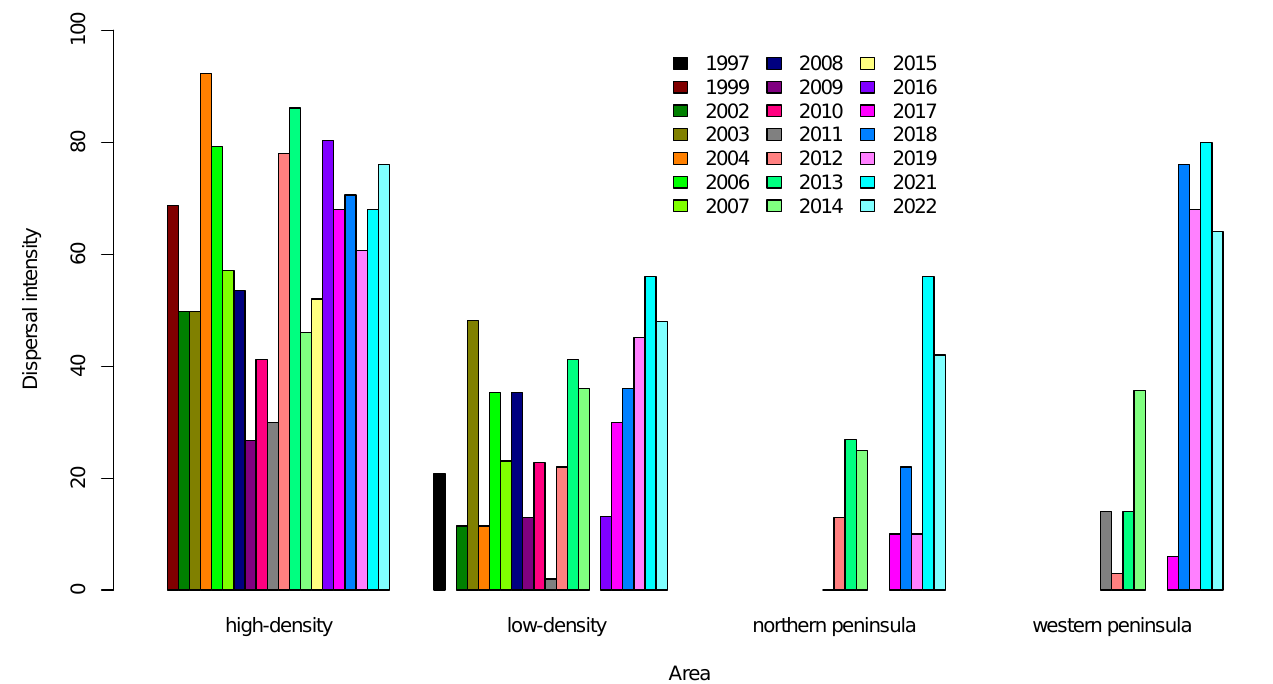
Figure 5. Dispersal intensities by the Balearic lizard in the four main areas of Aire Island during the entire study period (1999–2022, see more details in the text).